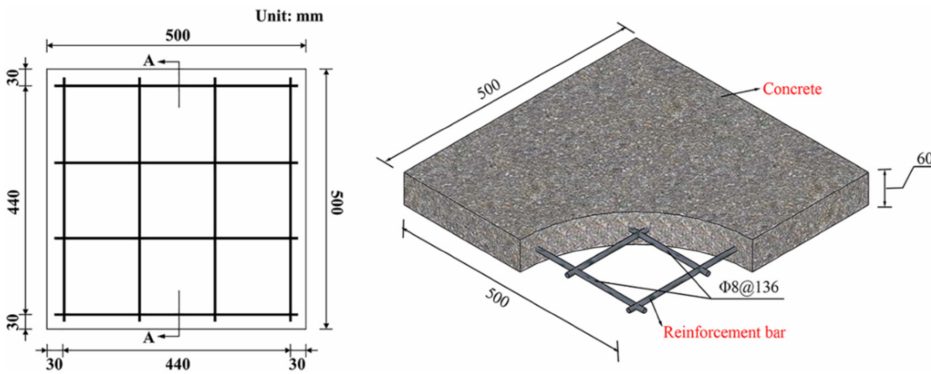
Figure 9. Geometry and reinforcement of the RC